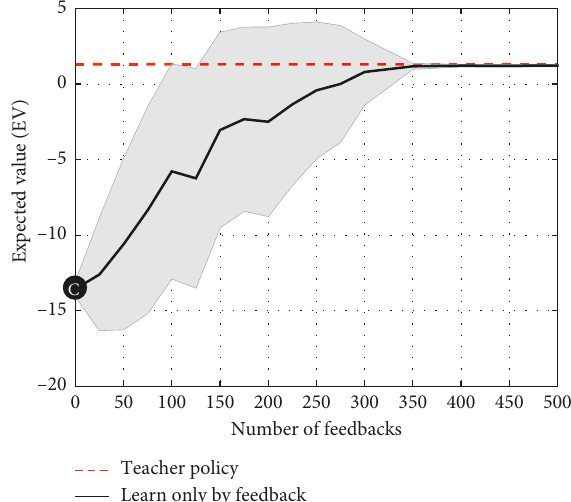
Figure 7: The performance of IRLDC framework when learning only from evaluative teacher’s feedback. This is the case where no demonstration is available (point “C” in Figure 3).